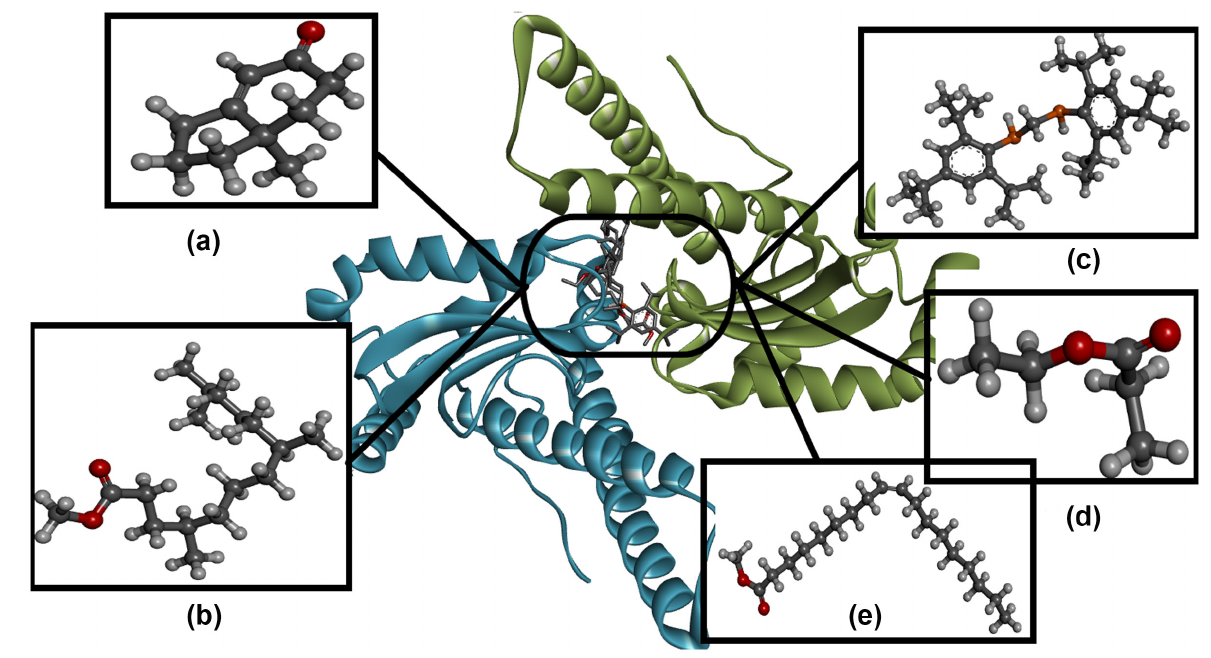
Figure 7. Docking pose scores of the studeid ligands ( a ) MHI, ( b ) MTTP, ( c ) MTP, ( d ) PAE and ( e ) OAM with target protein 1AR5.